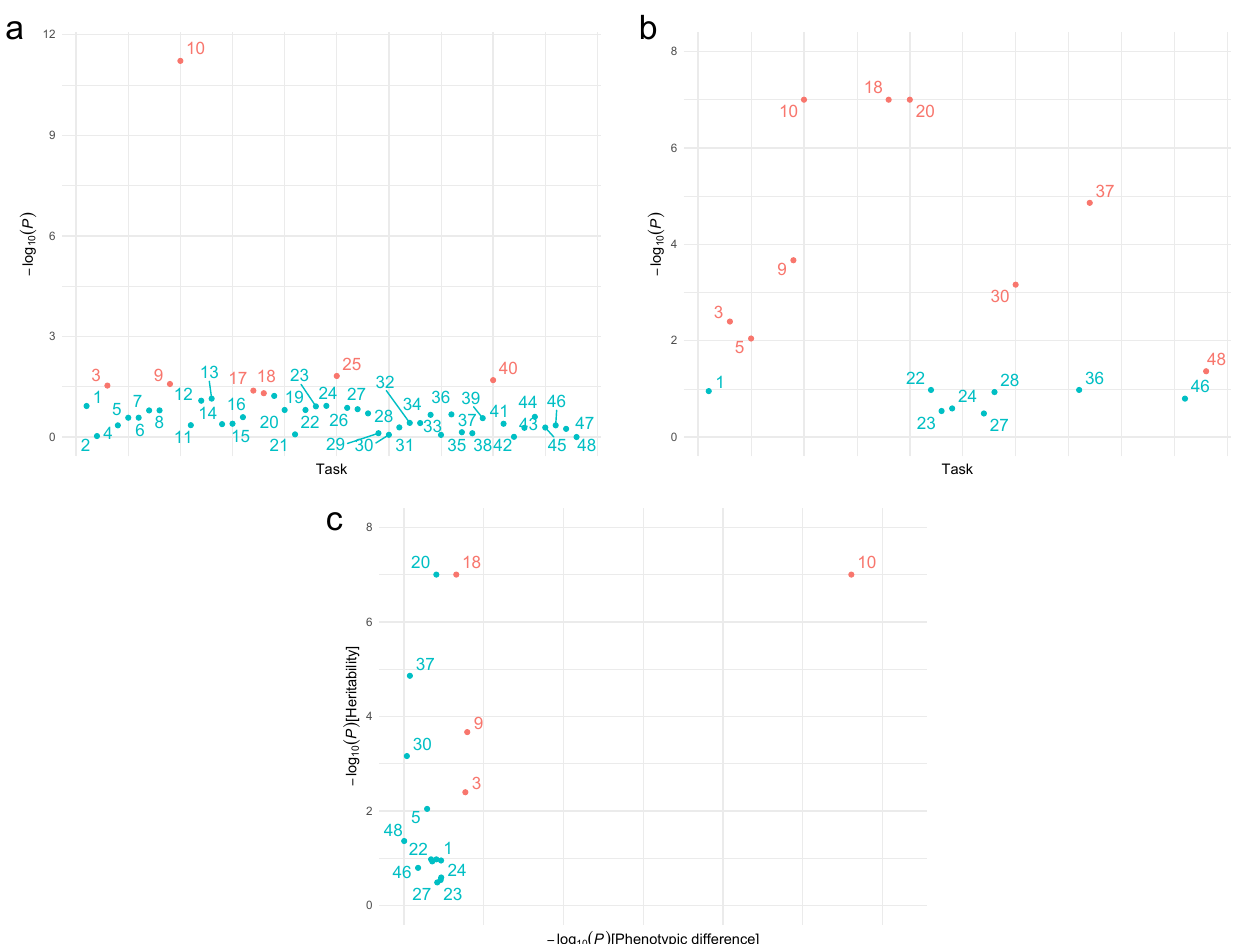
Figure 1. Neuropsychological tasks where ( a ) ADHD affected individuals differed from controls; ( b ) genetic effects and hereditary transmission are present; and ( c ) fulfil the requirements to be considered as potential endophenotypes are shown in orange. Displayed numbers correspond to task # in Table